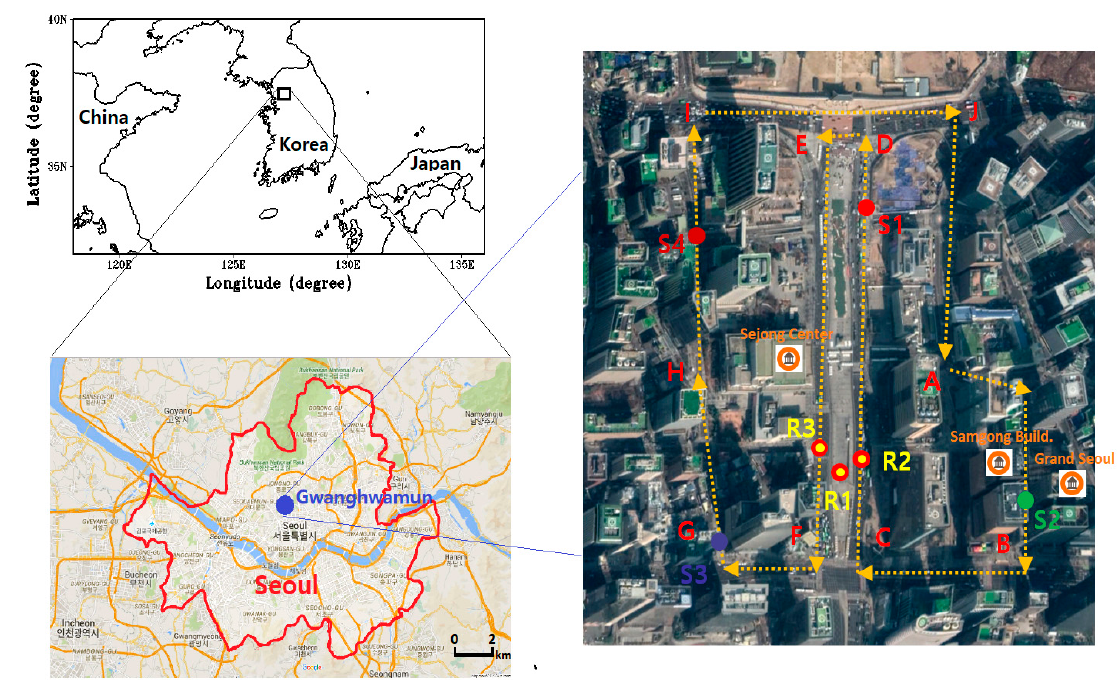
Figure 1. Map of the study area—Gwanghwamun,